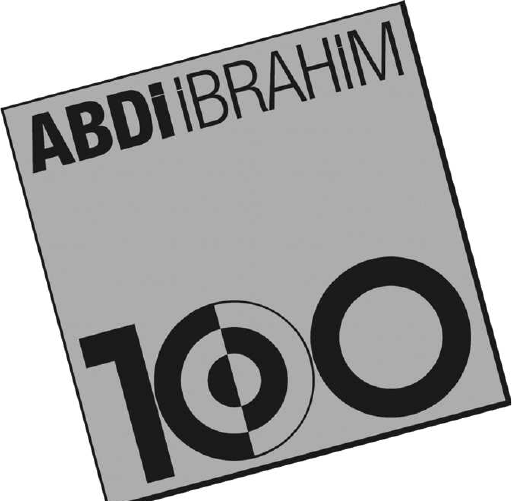
Fig. 4. Massimo Vignelli: “Abdi (cid:250) brahim 100 th Anniversary Emblem and Logotype”